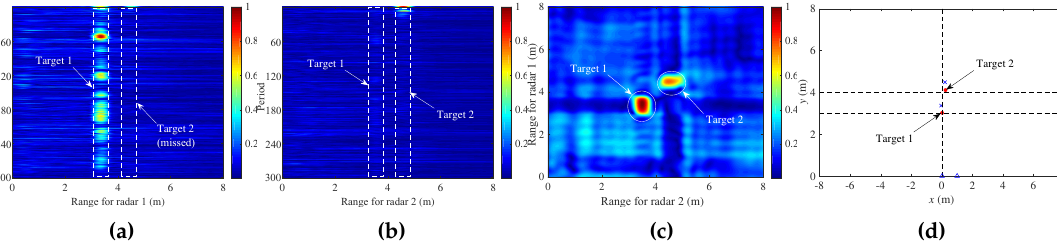
Figure 12. Results of Experiment 2.1 with 1 m interval between two radars: ( a ) range profile plane for Radar 1; ( b ) range profile plane for Radar 2; ( c ) cross-correlation image; and ( d ) localization result.